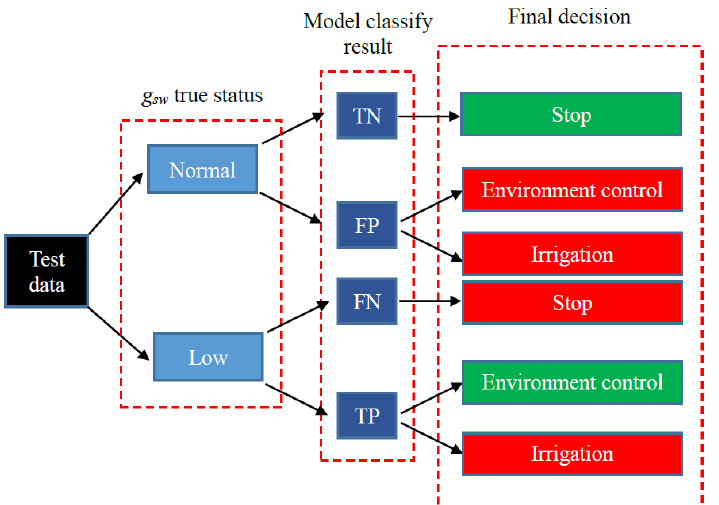
Figure 1. Tree diagram of the whole system evaluation. TN is true negative (the true g sw status of the tomato was “normal,” and the model also classified it as “normal”); FP is false positive (the true g sw status of the tomato was “normal,” but the model classified it as “low”); FN is false negative (the true g sw status of the tomato was “low,” but the model classified it as “normal”); and TP is true positive (the true g sw status of the tomato was “low,” and the model also classified it as “low”). In the final decision box, a decision with a green background is the correct decision and a decision with a red background is the wrong